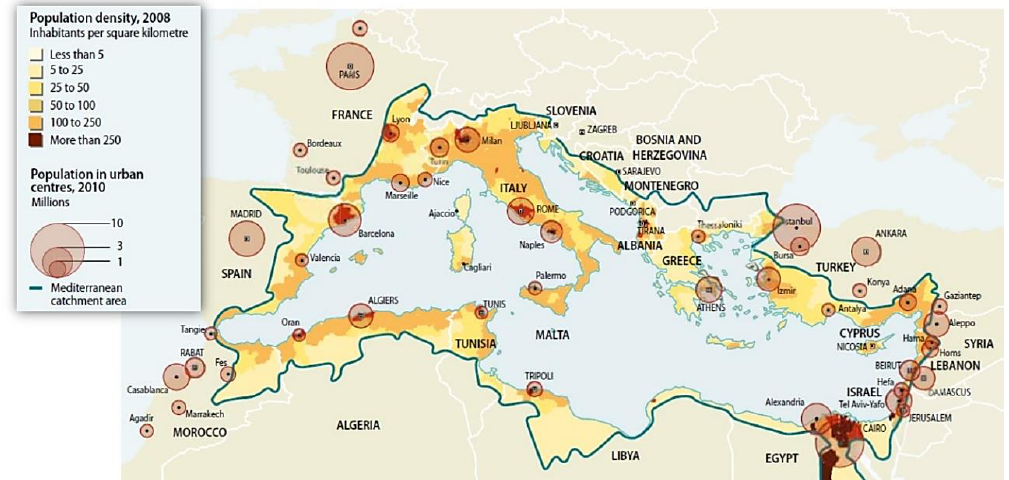
Figure 3. Population densities of Mediterranean countries, including Mediterranean MENA countries; source [19] .